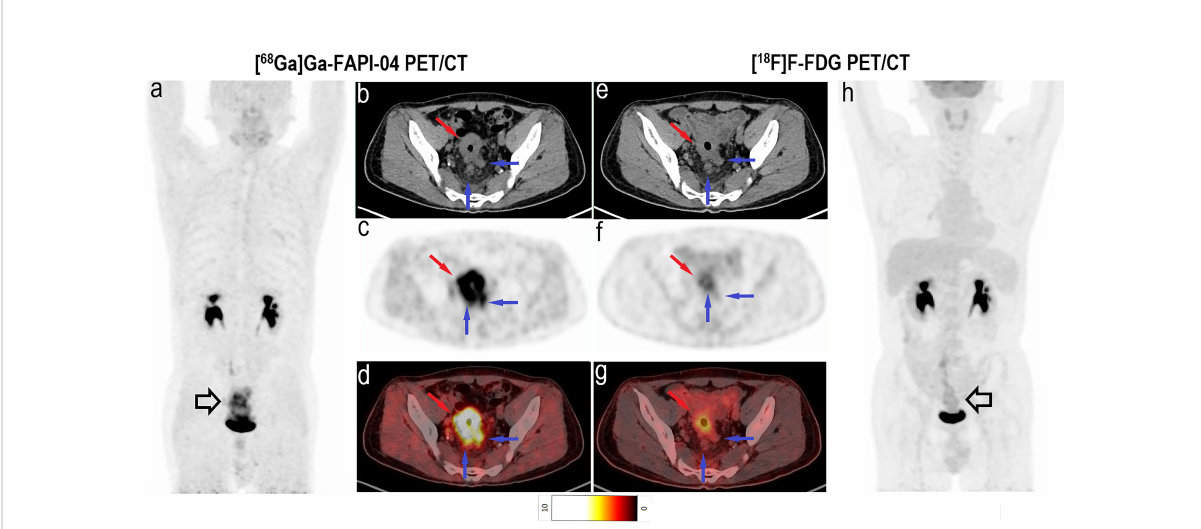
FIGURE 2 Images of a 49-year-old man with rectal mucinous carcinoma for staging. (A) Mean intensity projection images of [ 68 Ga]Ga-FAPI-04 PET/CT scan. (B – D) Axial CT, PET and fused images of [ 68 Ga]Ga-FAPI-04 PET/CT scan. (E – G) Axial CT, PET and fused images of [ 18 F]F-FDG PET/CT scan. (H) Mean intensity projection images of [ 18 F]F-FDG PET/CT scan. Compared with [ 18 F]F-FDG PET/CT, [ 68 Ga]Ga-FAPI-04 PET/CT exhibits the primary lesion (hollow black and red arrows) and suspicious lymph nodes (hollow black and blue arrows) more clearly because of the higher tracer uptake. The SUV max of primary lesions was 14.6 for [ 68 Ga]Ga-FAPI-04 and 4.4 for [ 18 F]F-FDG PET/CT. The [ 68 Ga]Ga-FAPI-04 PET/CT images also depict more intense tracer uptake in suspicious lymph nodes than [ 18 F]F-FDG PET/CT images, with SUV max values of 5.6 – 6.0 and 1.5 – 2.0,